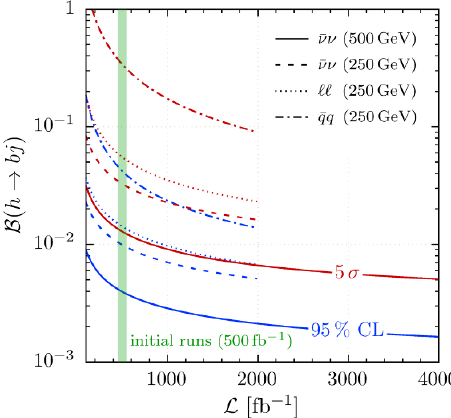
Figure 6. Comparison between the expected 95 % CL exclusion (blue) and 5 (cid:27) discovery (red) reaches on ( h bj ) for the various channels as a function of total integrated luminosity speci(cid:12)c B ! for the given centre-of-mass energy. The polarisation sharing is scenario 1 and 2 for the channels at p s = 250 GeV and 500 GeV, respectively. The plot assumes (cid:15) syst = 1